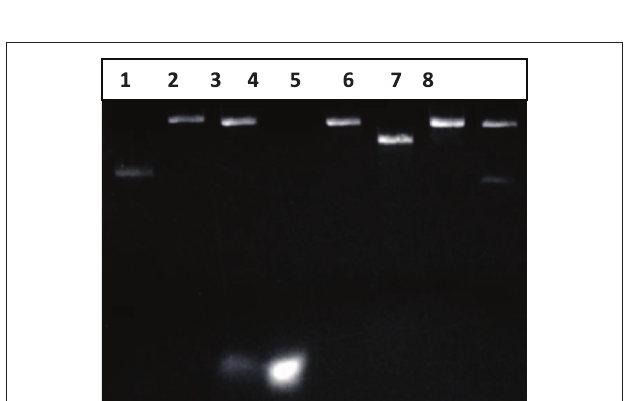
Figure 3 | identification of gap DNA. Lane 1: 200 ng of pWDAH1A plasmid; Lane 2: Nt.BstNBI-digested pWDAH1A plasmid (Nick DNA), 200 ng; Lane 3: Nt.BstNBI-digested pWDAH1A plasmid + biotinylated Rem-seq oligo; Lane 4: flow-through of mixture of lane 3; Lane 5: gap DNA, 200 ng; Lane 6: NheI-digested pWDAH1A plasmid DNA (linear DNA); Lane 7: NheI digestion of 200 ng gap DNA; Lane 8: ligation of gap DNA. Two hundred nanograms of DNA loaded each lane.